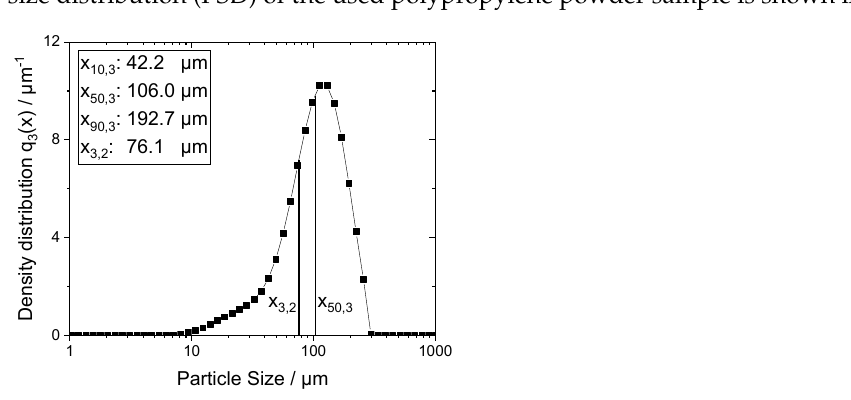
Figure 4. Particle size density distribution of PP feed material.